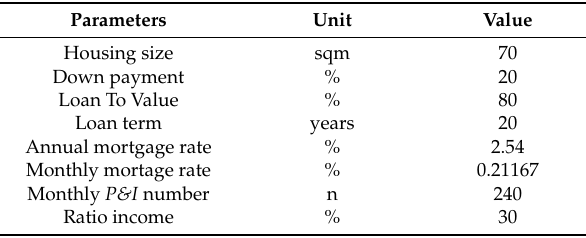
Table 2. Parameters for the T_I_ratio calculations